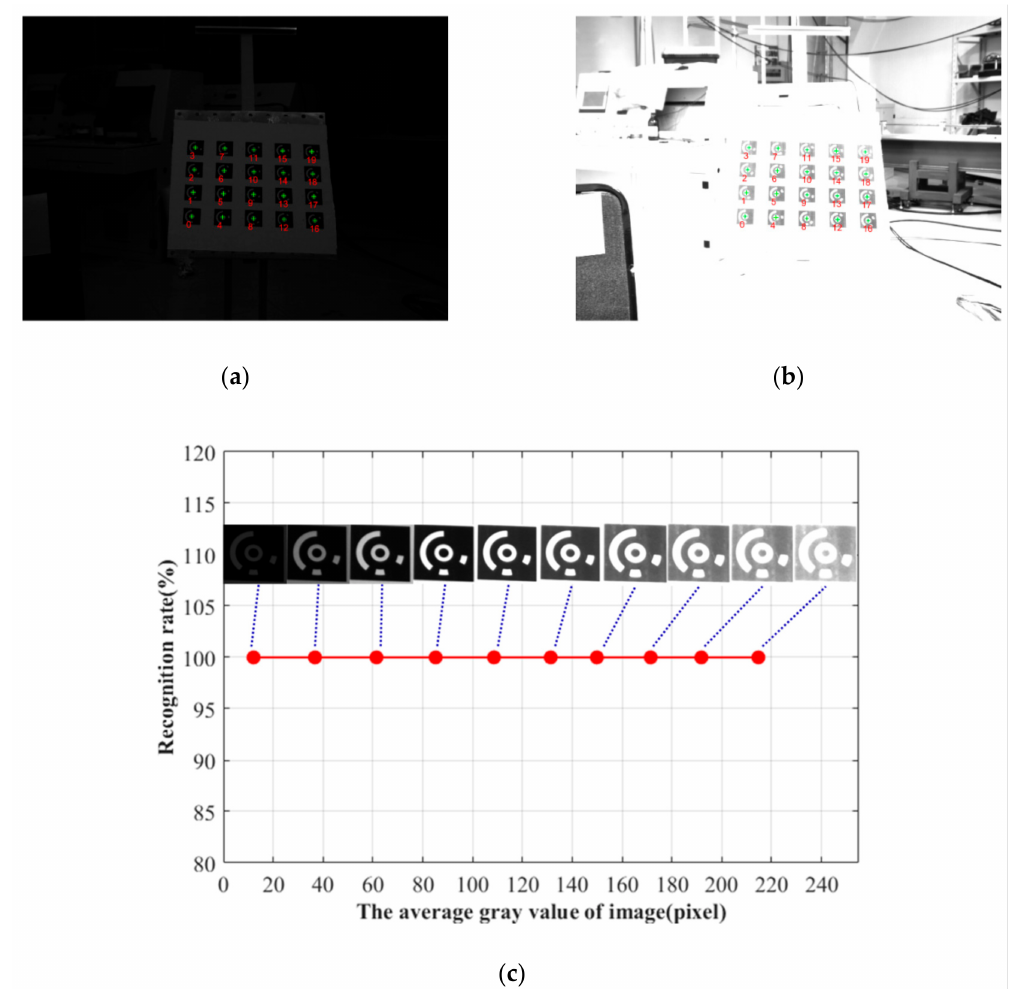
Figure 16. Experimental results of CCCT recognition under varying exposure levels: ( a ) Overexposed image; ( b ) Underex- posed image; ( c ) The recognition rate for different exposure